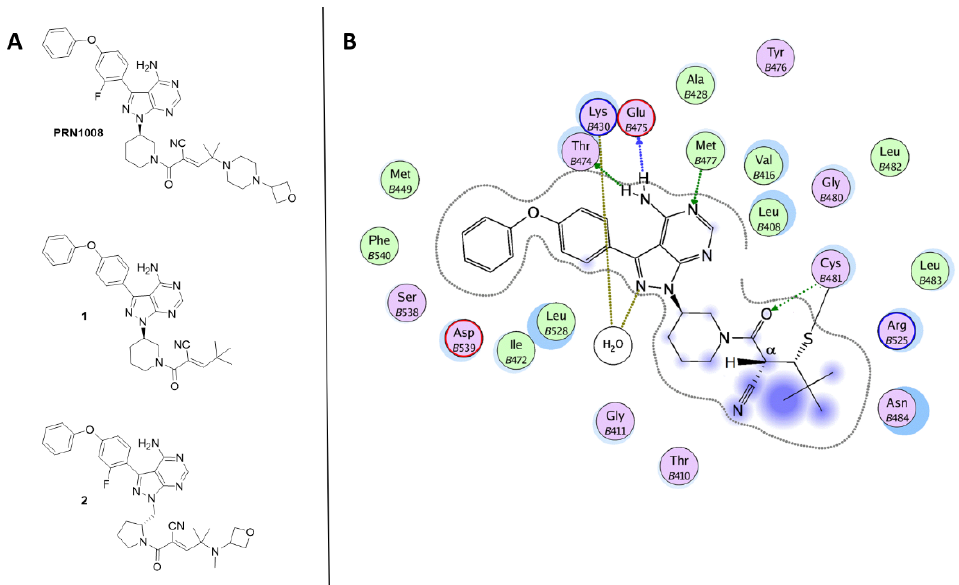
Figure 5. ( A ) Chemical structures of reversible covalent BtkIs PRN1008, 1 and 2. ( B ) Ligplot of the Btk-1 crystallographic complex.